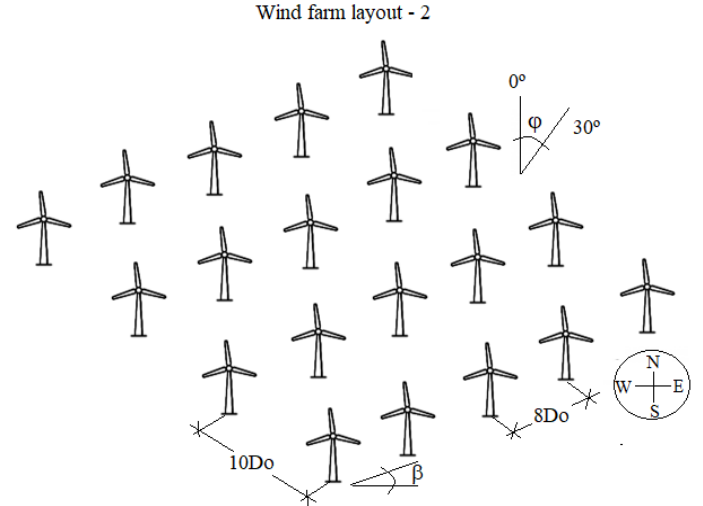
Figure 8. Modified wind farm (layout 2), considering row orientation angle.